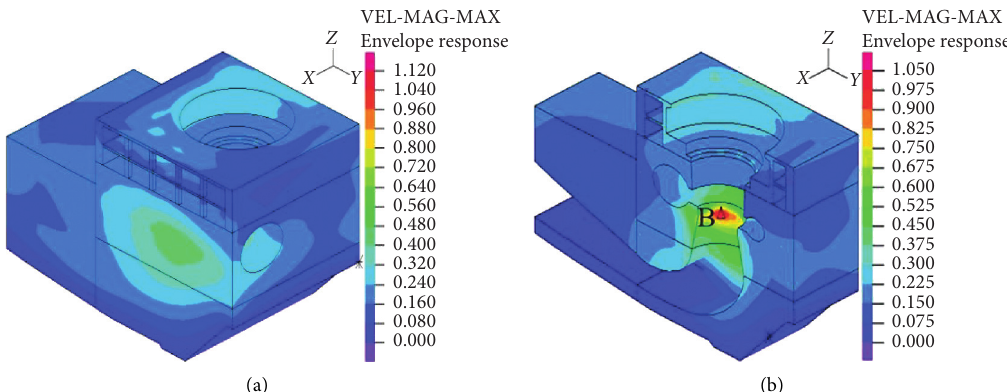
Figure 13: Extreme velocity distribution of the concrete structure (mm/s). (a) In three-dimensional view. (b) In section view.